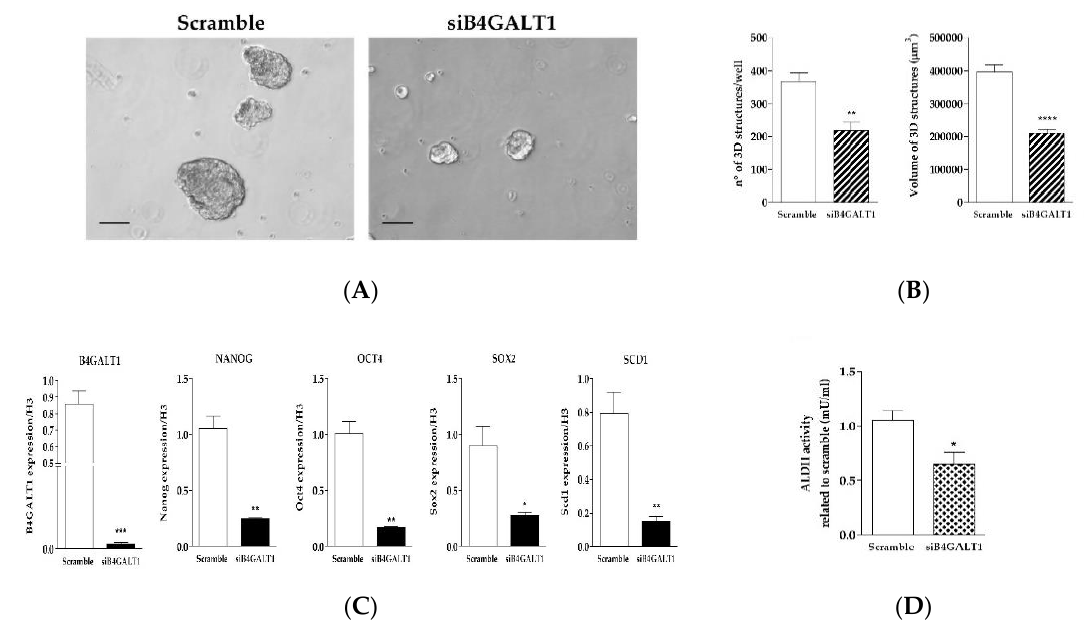
Figure 5. Knockdown of B4GALT1 RNA decreases the 3D structure formation and the expression of stemness markers. ( A ) Representative images of silencing of B4GALT1 reduction of 3D structure formation potential compared to the scramble of H460 cells. Scale bar = 100 µm. ( B ) Graphs show that silencing of B4GALT1 in 3D induces a decrease of volume and number of 3D spheroids. Number and volume of the 3D cells counted in each well after four days of culture. ( C ) Validation of B4GALT1 silencing in 3D cells, the results show a strongly decreases of stemness markers mRNA levels, such as Oct4, Sox2, Nanog, and SCD1. Expression of each gene was normalized to that of H3. ( D ) ALDH activity decrease substantially in 3D siB4GALT1 vs. Scramble cells. Experiments were performed in triplicate, and the background interference and the blank value were subtracted from the absorbance of the samples. In the bar plots, the mean ± standard error of mean (SEM) was shown from at least three independent experiments * p < 0.05, ** p < 0.005, **** p < 0.0001 (vs. scramble).